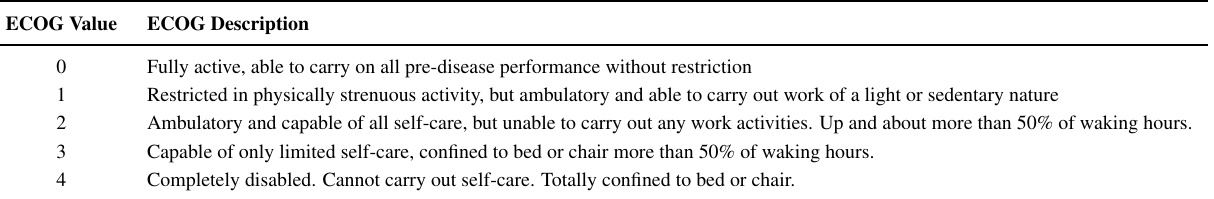
Table 5. Eastern Cooperative Oncology Group (ECOG)